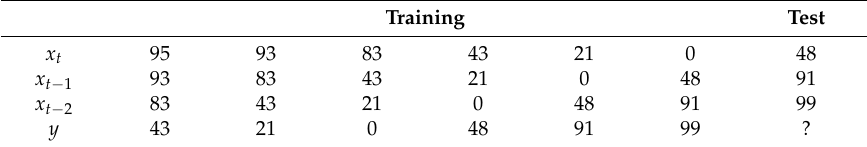
Table 3. Input and output values of supervised learning function using three prior time steps.